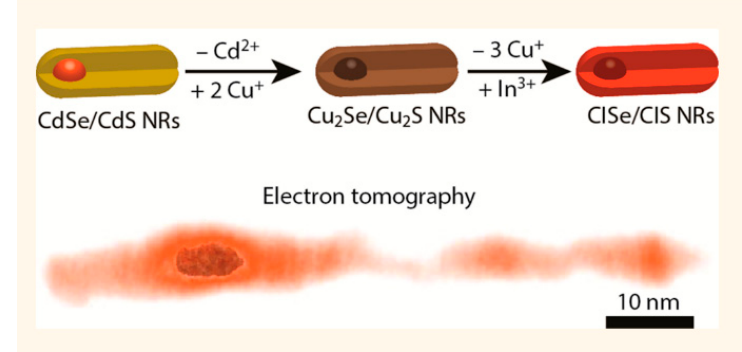
Figure 10. Scheme of the synthesis of the CISe/CIS dot-in-rod heterostructure. Reproduced with permission from [162]. Copyright American Chemical Society, 2015.